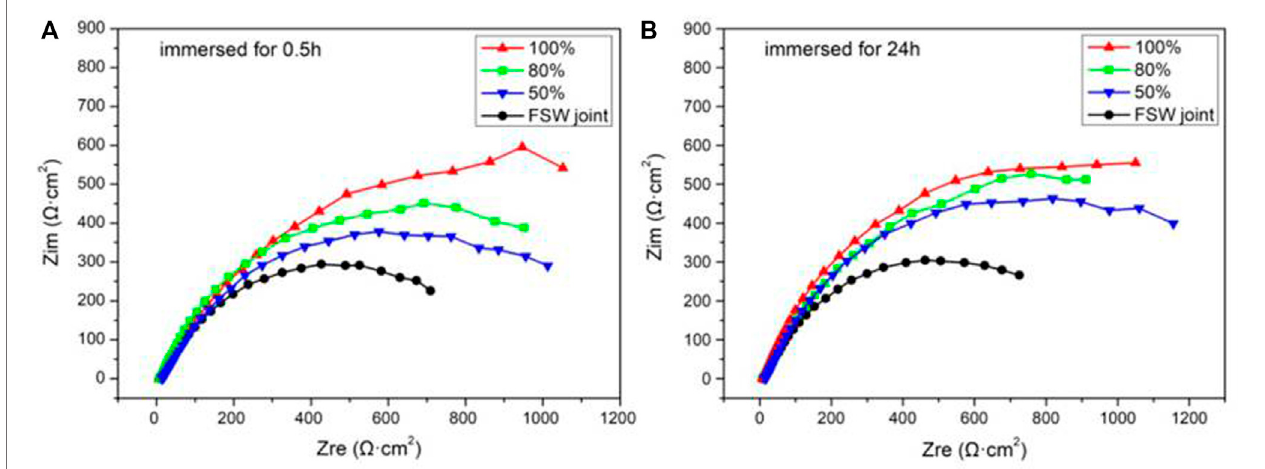
FIGURE 7 | Nyquist plots of FSW joint and Ni coatings immersed for 0.5 h (A) and 24 h (B) in simulated seawater.